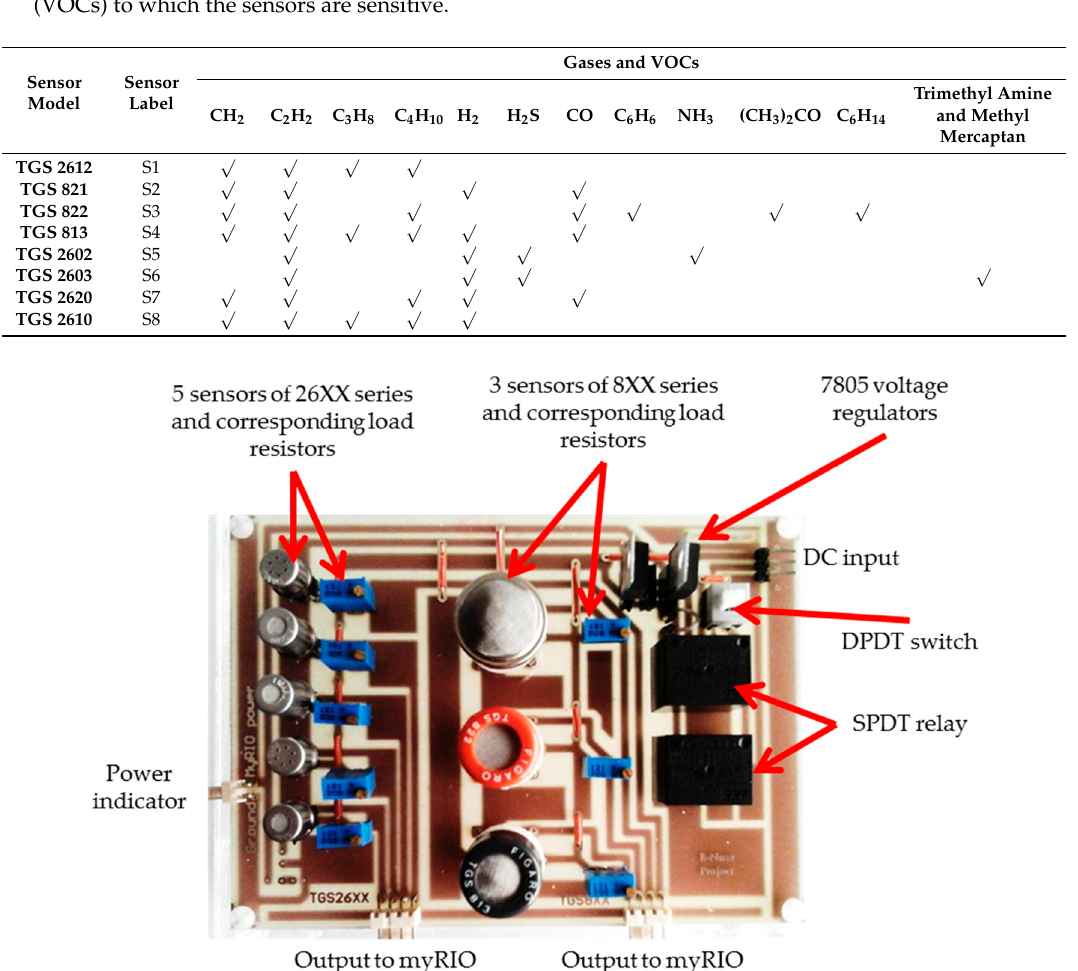
Table 1. Figaro gas sensors used in the E-Nose design and the gases or volatile organic compounds (VOCs) to which the sensors are sensitive.